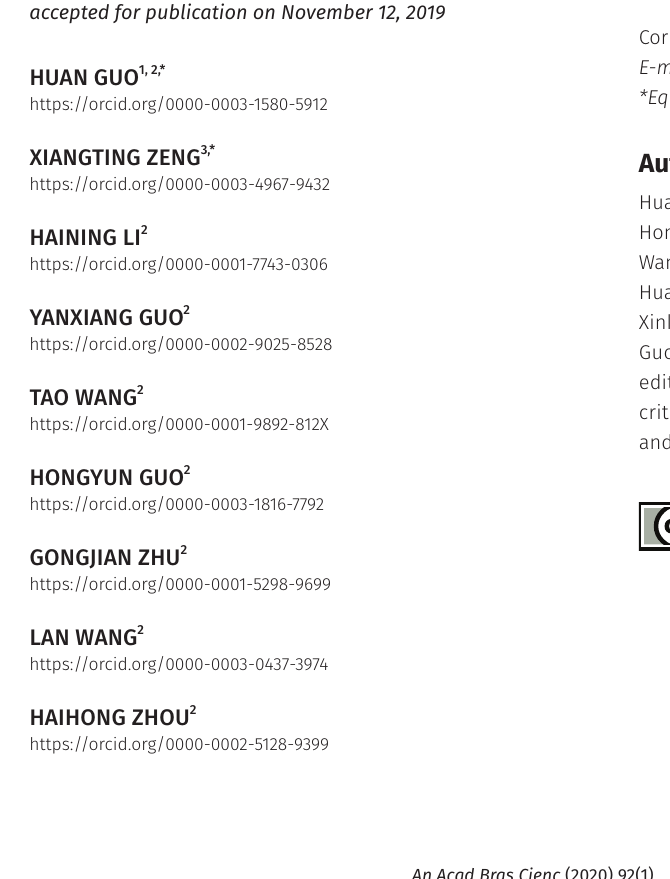
Figure S1. Relative expression of miR-1273g-3p and target gene